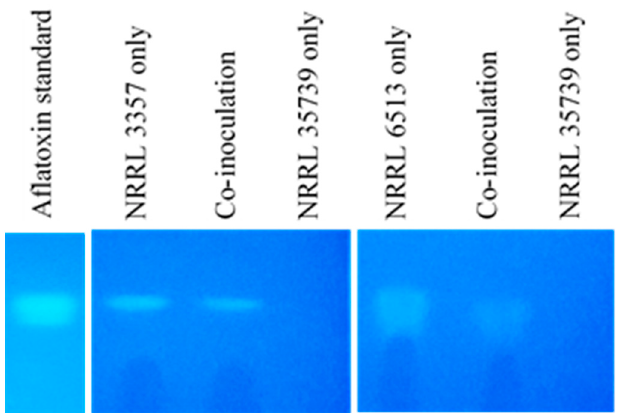
Figure 1. Weak biocontrol ability of A. flavus NRRL 35739. The strain was tested against NRRL 3357 (middle) and NRRL 6513 (right). Co-inoculation of an aflatoxigenic strain with NRRL 35739 did not greatly affect aflatoxin accumulation in the media. The retention factors of the aflatoxin extracts were similar to that of the aflatoxin standard (left). Images are representative of three replicates.